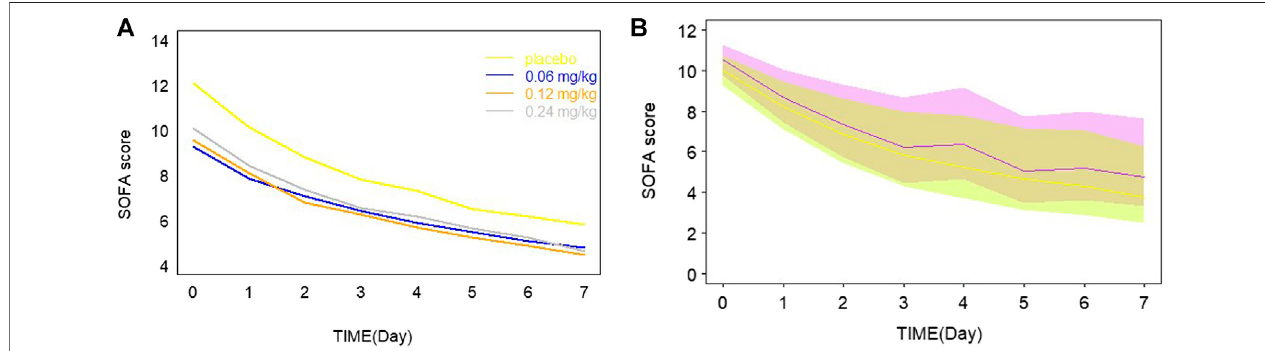
FIGURE 4 | (A) Typical model predictions plot overlaying the effect of placebo and different dosage. (B) The simulated pro fi les of SOFA score vs. time in the recommended 0.24 mg/kg drug groups and the placebo group in a panel. The purple line and shadow bounds represent the 30th, 50th, and 70th percentiles of SOFA score distribution in theplacebo group. Theyellowlineand shadow bounds represent the 30th, 50th, and 70th percentiles ofSOFAscore distribution inthe 0.24 mg/kg drug